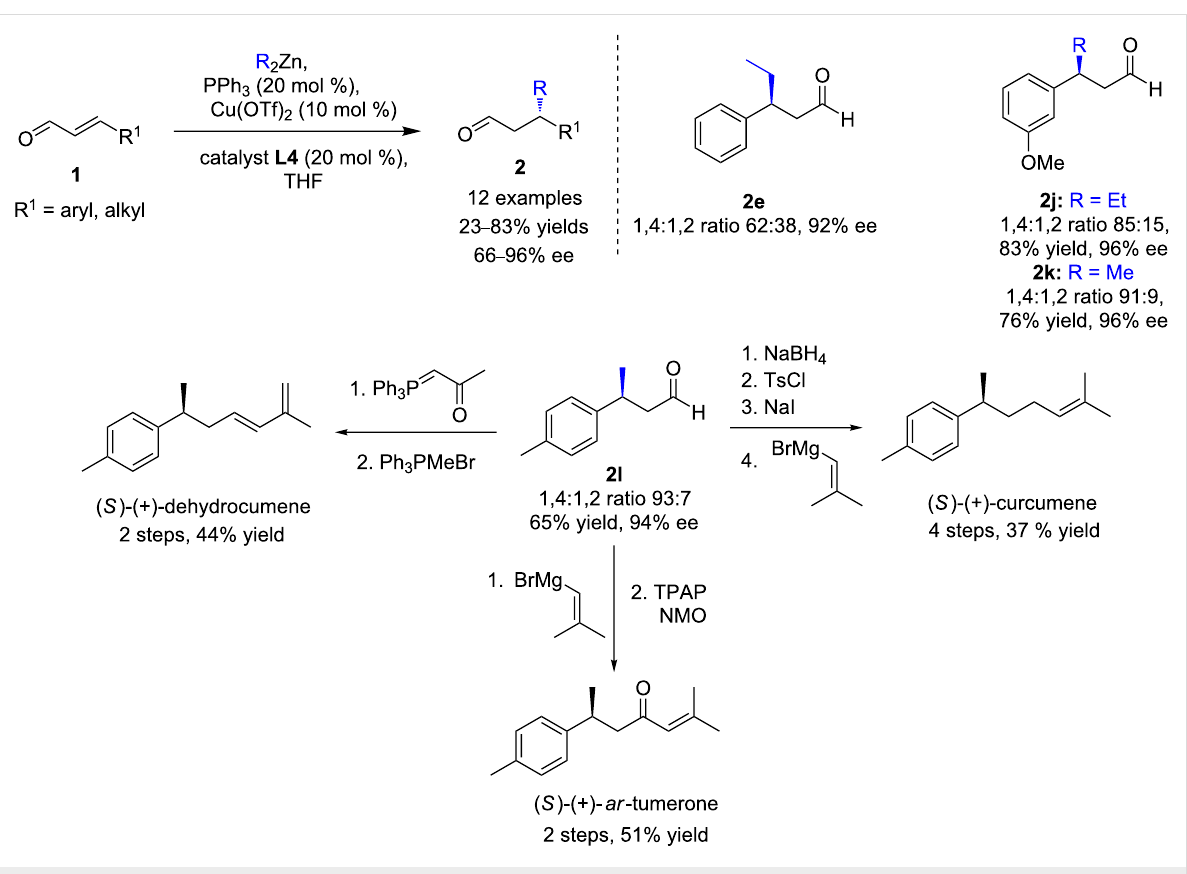
Scheme 4: Combination of copper and amino catalysis for enantioselective β -functionalizations of